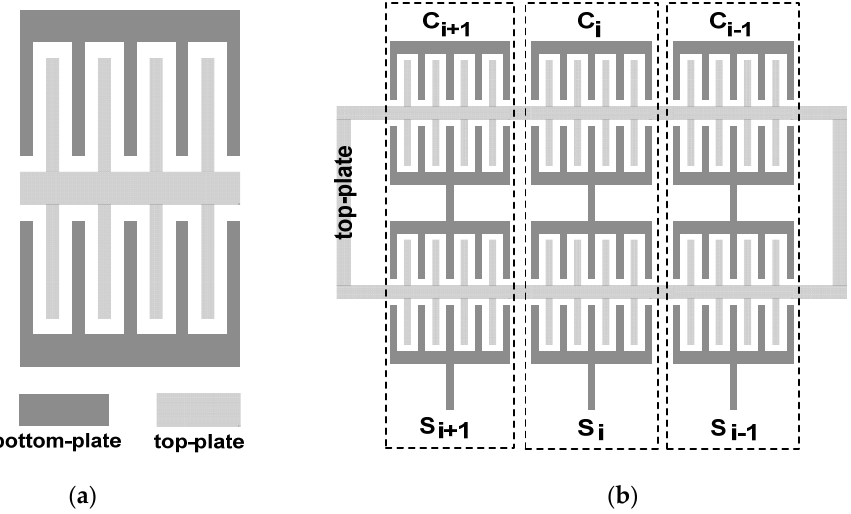
Figure 17. DAC capacitor. ( a ) Unit capacitor structure; ( b ) floorplan of DAC capacitor array.